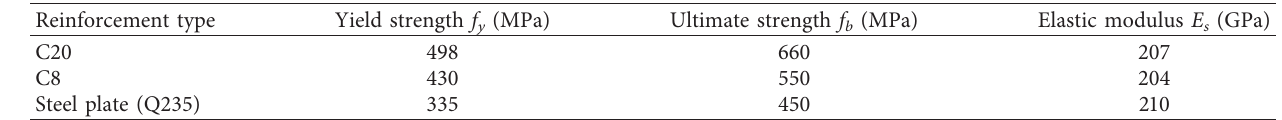
Figure 4: Specimen size and section reinforcement: (a) cast-in-place specimen RC, (b) specimens PRC1-1, PRC2-1, and PRC3-1, and (c) specimens PRC1-2, PRC2-2, and PRC3-2. Table 2: Steel material